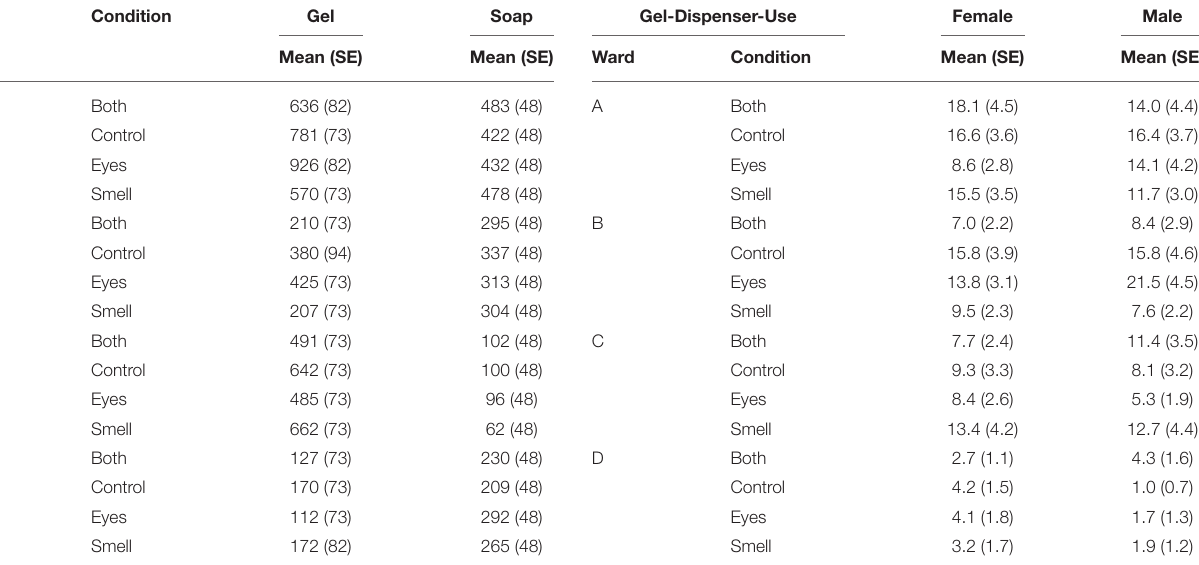
TABLE 4 | Model means and standard errors (SE) pertaining to gel-dispenser-use and soap-dispenser-use, broken down by treatment condition, ward, and gender.